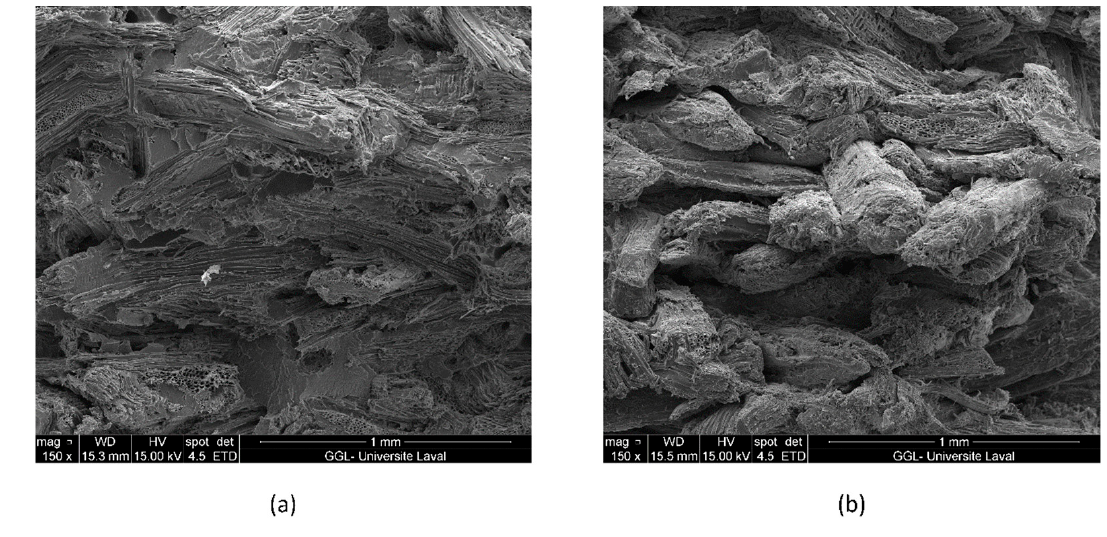
Figure 8. Scanning electron microscope (SEM) images of the treated fiber composite cross-sections with different fiber content: ( a ) 75 wt% and ( b ) 100 wt%.